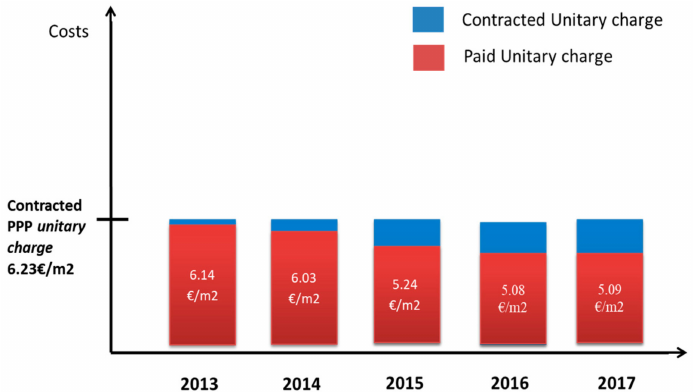
Figure 4. Historical ratio of contracted and paid unitary charges. Source: Authors’ calculation (based on data available in Appendix A: Table A2).